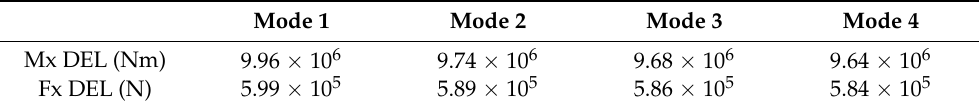
Table 5. The DEL